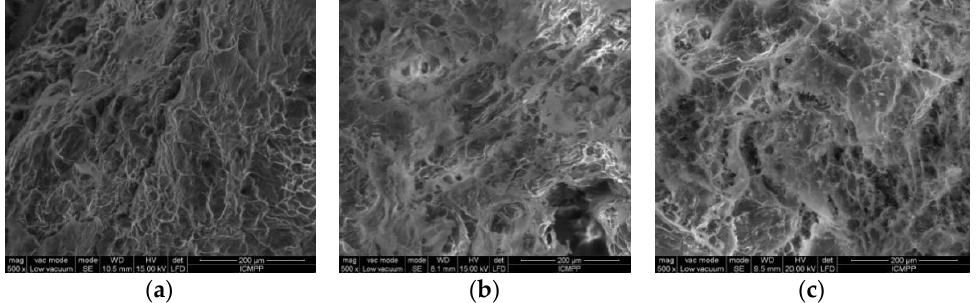
Figure 3. SEM microscopy of the freeze-dried gels: ( a ) S1, ( b ) S2, ( c ) S3.